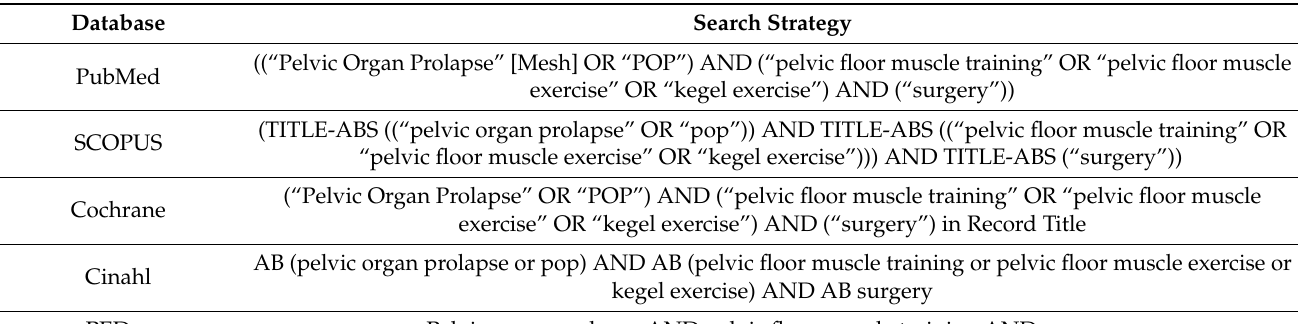
Table 1. Search strategies on each